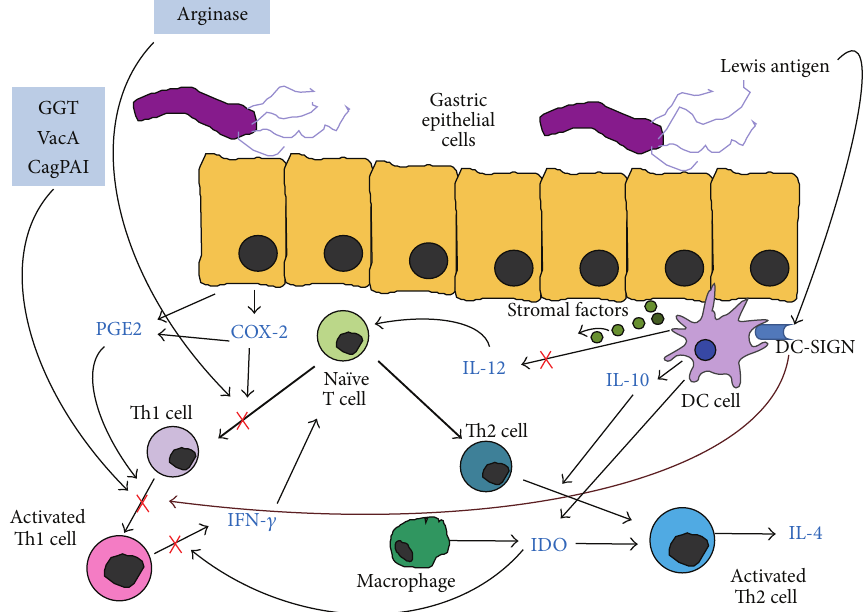
Figure 1: The biased Th1/Th2 cells response. The vacuolating cytotoxin (VacA) and the gamma-glutamyl transpeptidase (GGT) secreted by H. pylori inhibit Th1 cell proliferation by inducing a G1/S cell cycle arrest [28–31], while the cytotoxin-associated gene pathogenicity island ( cag PAI) promotes Th1 death by the induction of Fas ligand [33]. The committed T na¨ıve cells are unable to differentiate into Th1 line due to the enzyme arginase possessed by H. pylori [32]. H. pylori -induced cyclooxygenase- (COX-) 2 activation, alone and in conjunction with its product prostaglandin (PGE), suppresses Th1 polarization [34, 35, 39]. The H. pylori -induced expression of indoleamine 2,3 dioxygenase (IDO) limits the IFN- 𝛾 production by Th1 cells and favours the activation of Th2 cells [36]. Stromal factors suppress the IL-12 production by mucosal dentritic cells (DCs) [37], whose dendritic cell-specific ICAM-3-grabbing nonintegrin (DC-SIGN) receptor interacts with Lewis antigen expressed by H. pylori thus blocking Th1 cell recruitment